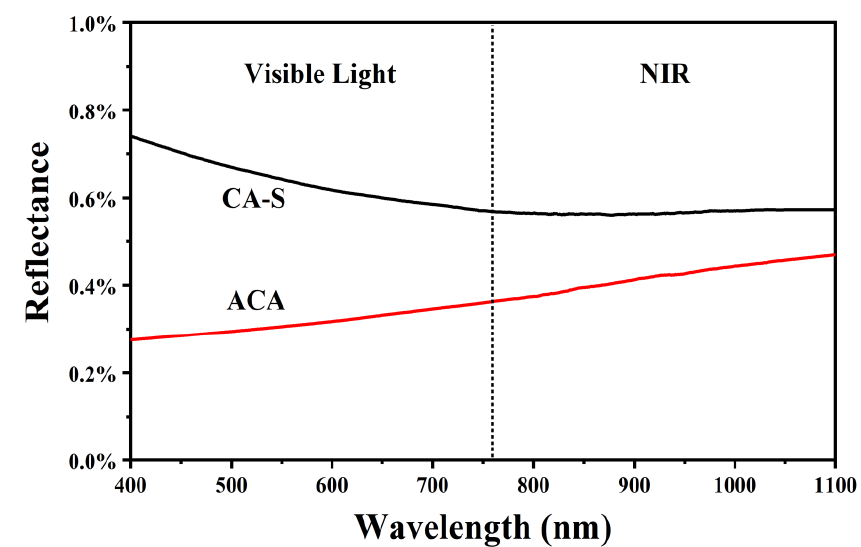
Figure 3. Reflection of CA-S and ACA.